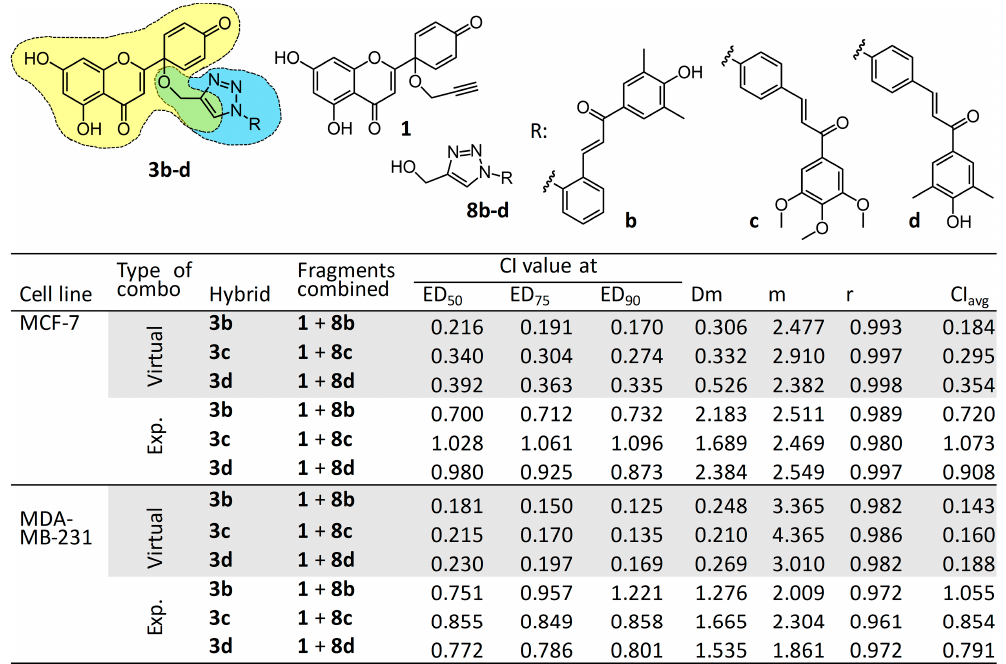
Figure 1. Comparative analysis of the cytotoxic activity of the hybrid compounds 3b–d by the Chou-Talalay method with that of their fragments. Results of a virtual (hybrid vs. fragments alone) and an experimental (Exp.: equimolar mixture of fragments vs. fragments alone) combination study are shown at 50%, 75%, and 90% of inhibition. CI: combination index; 0 < CI < 1, CI = 1, and CI > 1 represent synergism, additivity, and antagonism, respectively. Dm, m, and r represent the antilog of the x-intercept (activity), slope (shape of the dose-e ff ect curve), and linear correlation coe ffi cient (conformity of the data) of the median e ff ect plot, respectively [38]. CI avg = (CI 50 + 2 × CI 75 + 3 × CI 90 ) / 6. The lowest CI avg value demonstrates the highest added benefit of hybridization in terms of in vitro cytotoxic